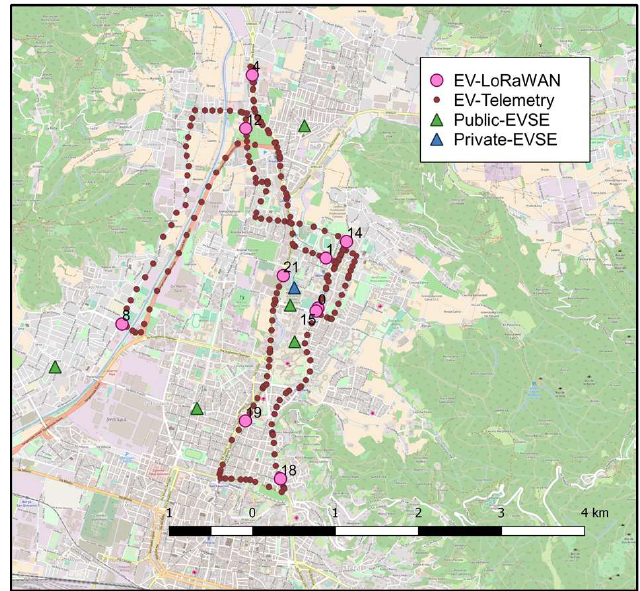
Figure 14. The georeferenced distance (km) travelled by the EV. The pink circles represent the value of the total distance travelled by the EV during the test, estimated from the geographical coordinates transmitted every 5 min, while the red circles represent the measured value recorded by the on-board telemetry system every 1 s. The experiment was carried out in the city of Brescia, north part of Italy. EV: Electric Vehicle, EVSE: EV Supply Equipment.